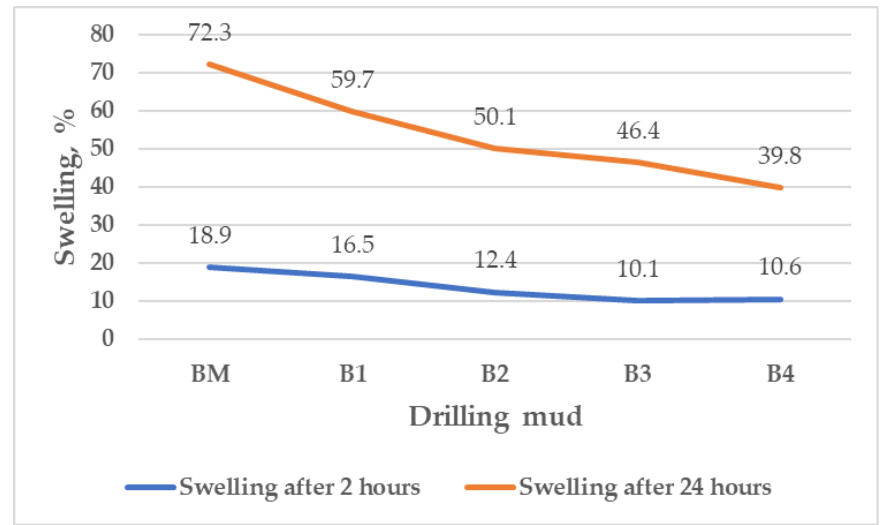
Figure 8. Pellet swelling in base mud and in mud with added MPP (particles from 0.1 to 0.16 mm) within 2 and 24 h at room temperature.